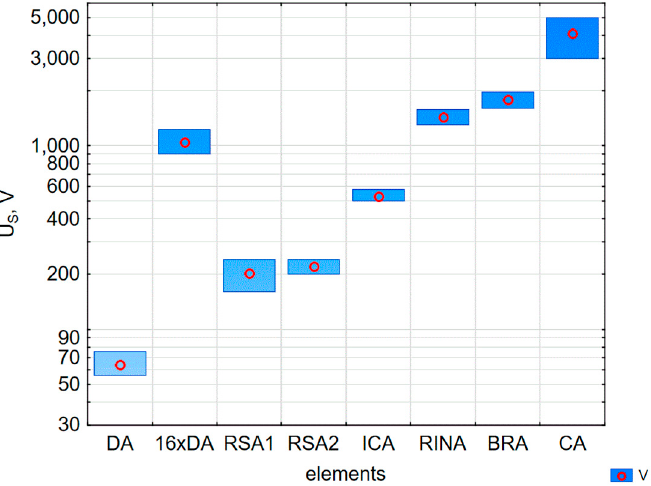
Figure 8. The results of the statistical analysis of damage of the integral parts of individual compo- nents of the type A lamp.